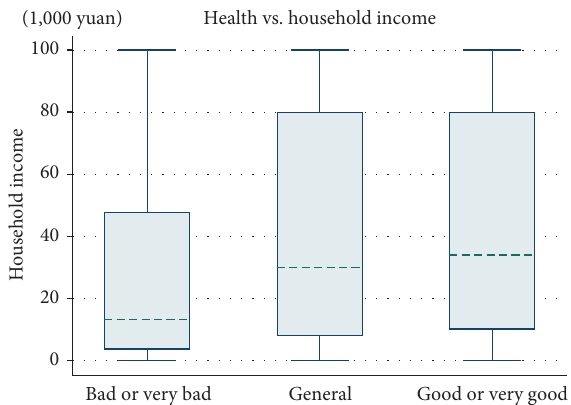
Figure 3: Household income and self-rated health Table 2: Model comparison based on the AIC, BIC, and log-likelihood of six regression models. Model